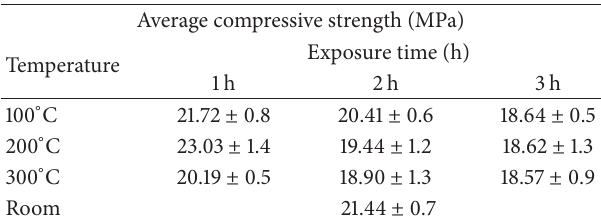
Table 3: Test results of the unconfined specimens.